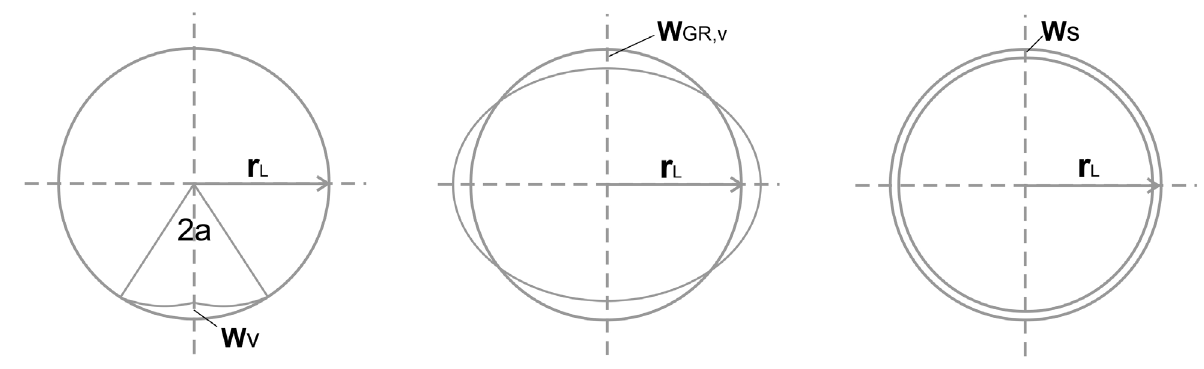
, b) ovalisation w , c) annular gap w v GR,v s